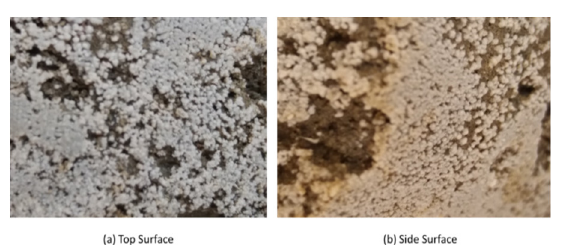
Fig. 9: Samples after twenty-two days of curing 3.5 Comparison BC Samples on Different Days As shown in Fig. 10(a-d), the layer on top surface is getting thicker day by day. This shows that bacteria feed calcium lactate and produce layer of calcium carbonate which seals micro void on top surface. It takes almost 2 months to produce complete thick sealed layer on overall cement